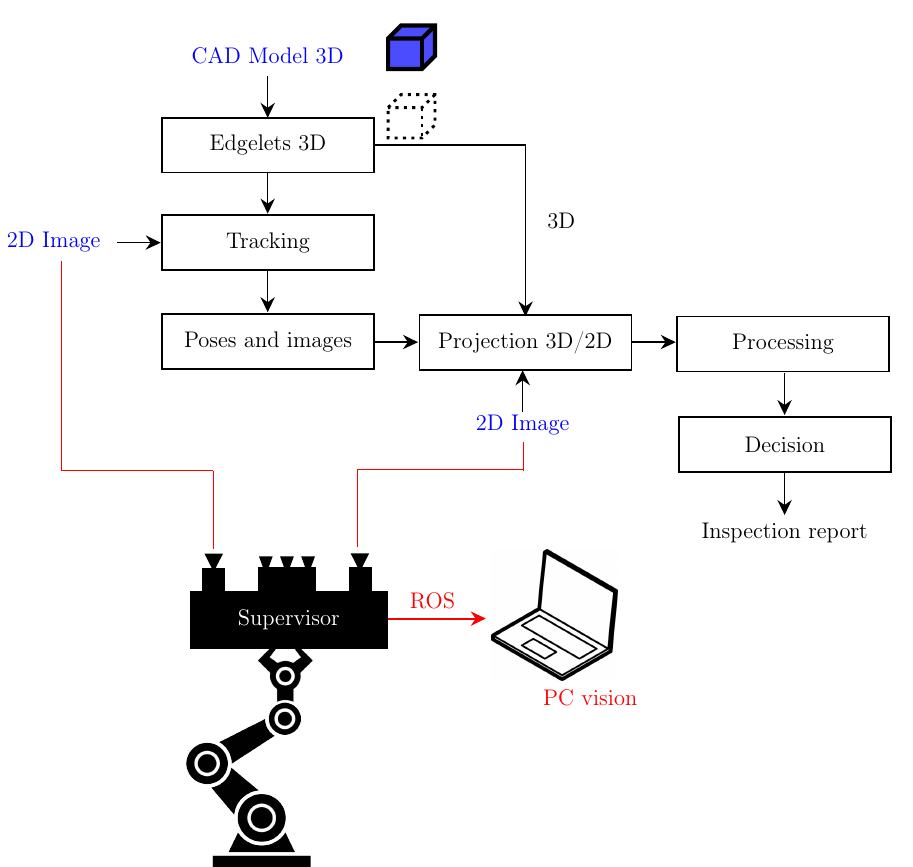
Figure 6. Overview of the detection phase during online processing using robot-based inspection.